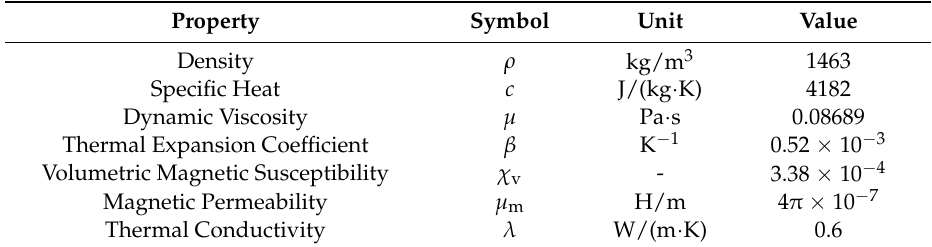
Table 1. Working fluid properties [8].